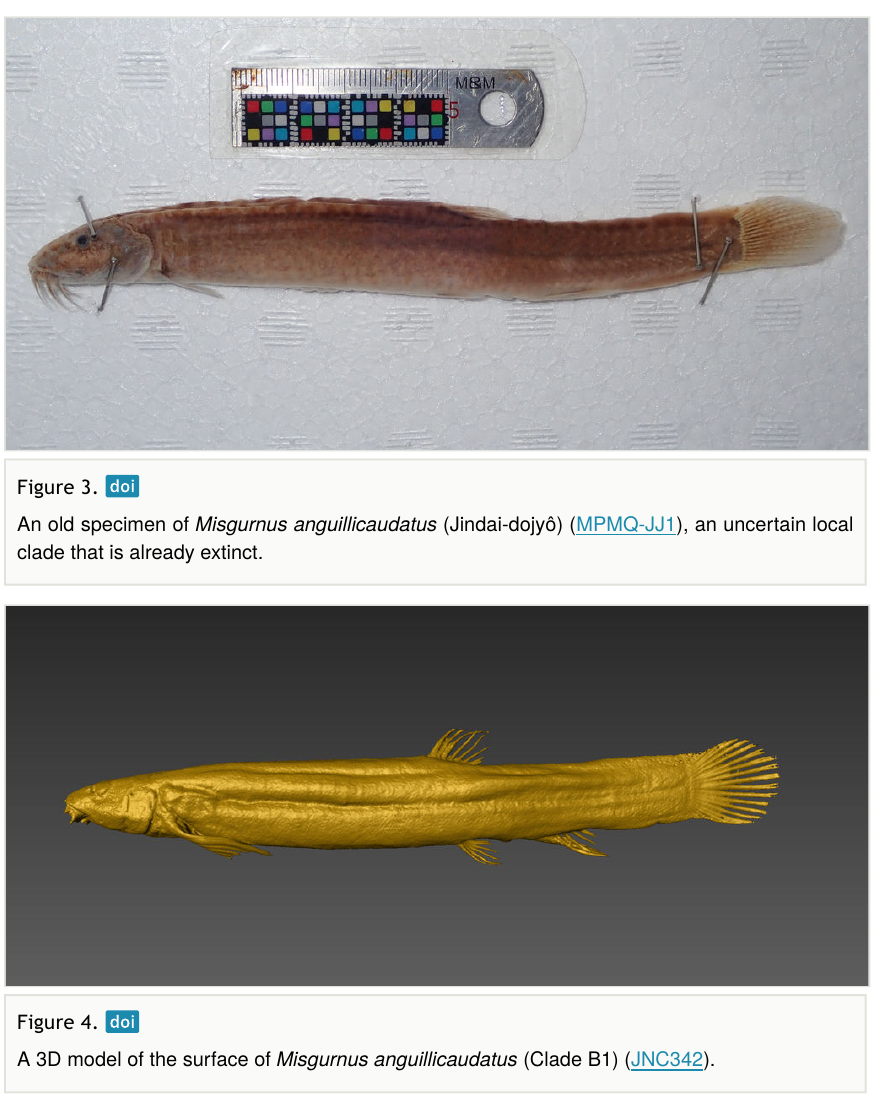
Sampling description: The specimens were generally captured by a hand-net in the fi eld. All the specimens were fi xed in 10% formalin and preserved in 70% ethanol.